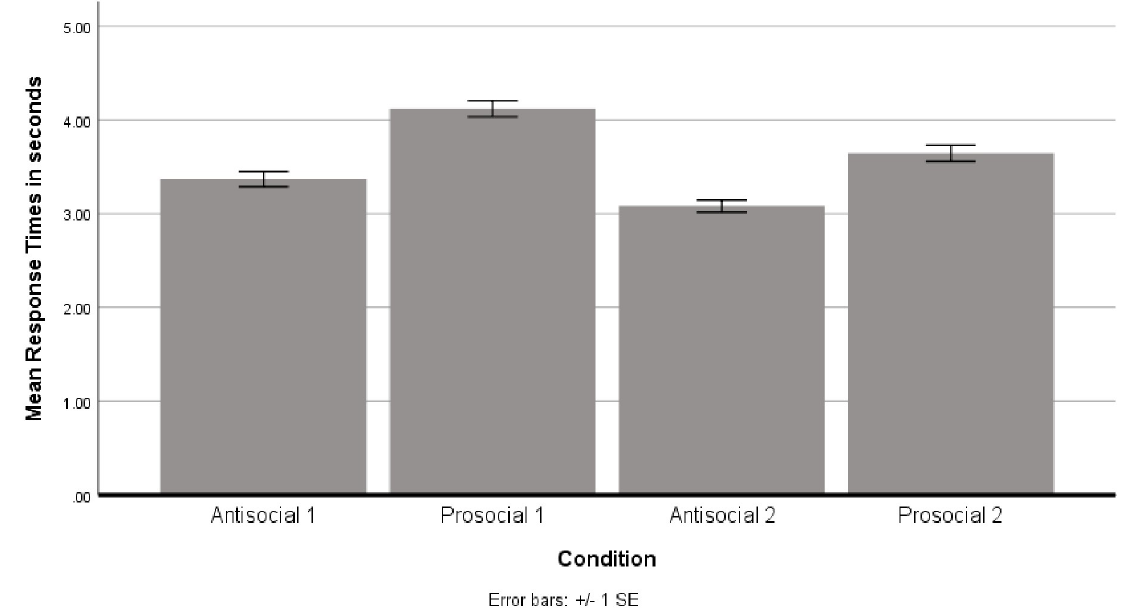
Fig 2. Response time differences during the different conditions in the IVR task. Bar height indicates the mean response time and the error bars indicate +/ − the standard error.